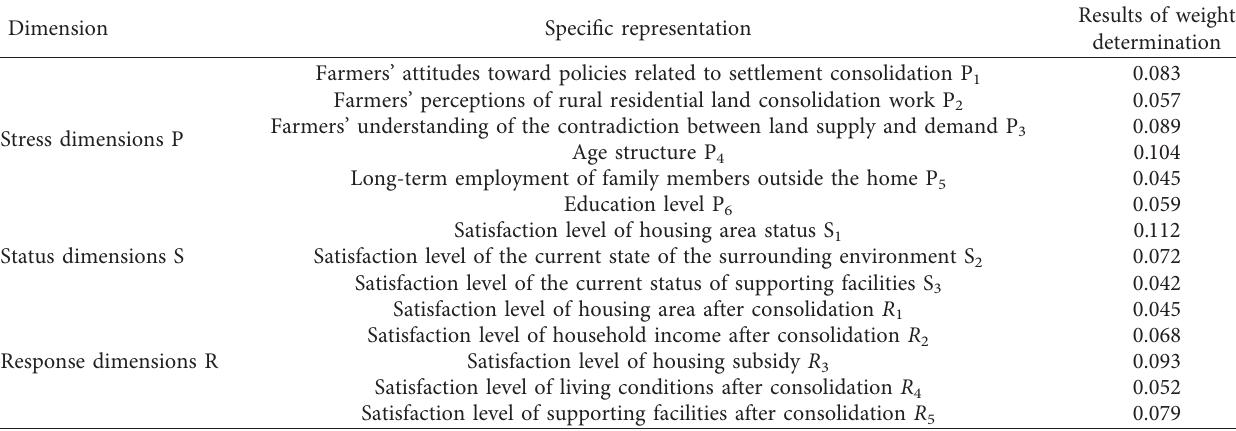
Table 8: Results of determining the weights of the factors in the structure of farmers’ willingness in the estimation of rural residential land consolidation